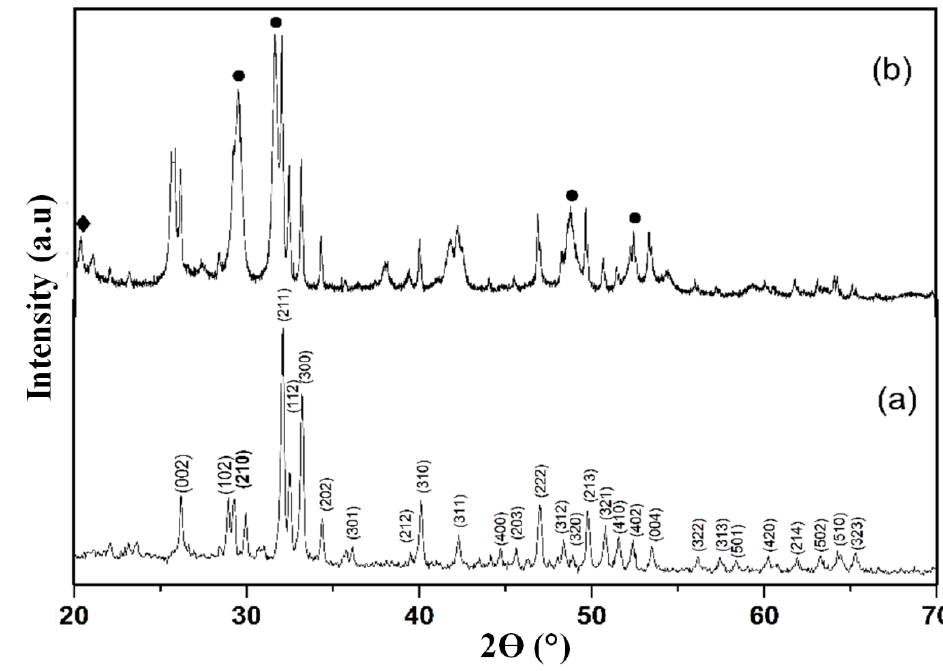
Figure 1. The XRD spectra of ( a ) pure HAP and ( b ) CS-HAP-CeO 2 heterostructure. The symbol ( ● ) indicates cerium oxide peaks whereas, ( (cid:7) ) represents chitosan peak.